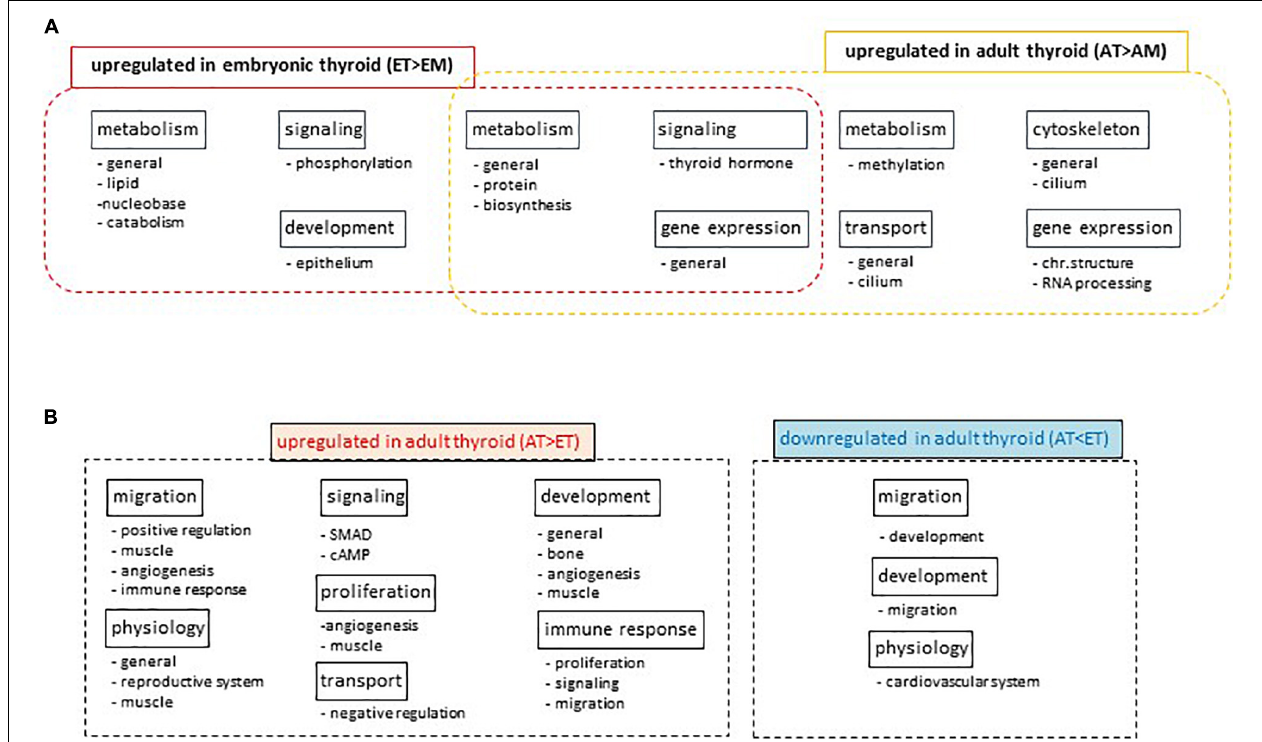
FIGURE 7 | Gene Ontology analyses. (A) Differential Gene Ontology analysis of lists of differentially expressed genes upregulated in adult thyroid samples compared to adult tissues mix (AT > AM) or in embryonic thyroid samples compared to embryonic tissues mix (ET > EM). Names of super-and subclusters of GO terms common and specific to adult and embryonic thyroids are shown. (B) Differential Gene Ontology analysis of lists of differentially expressed genes developmentally up- or downregulated specifically in the thyroid. Diagrams show the names of super-and subclusters of GO terms enriched in lists of genes differentially expressed in adult thyroids compared to embryonic thyroids (AT vs. ET) in comparison to the lists of genes differentially expressed in adult tissue mix compared to embryonic tissue mix (AM vs.